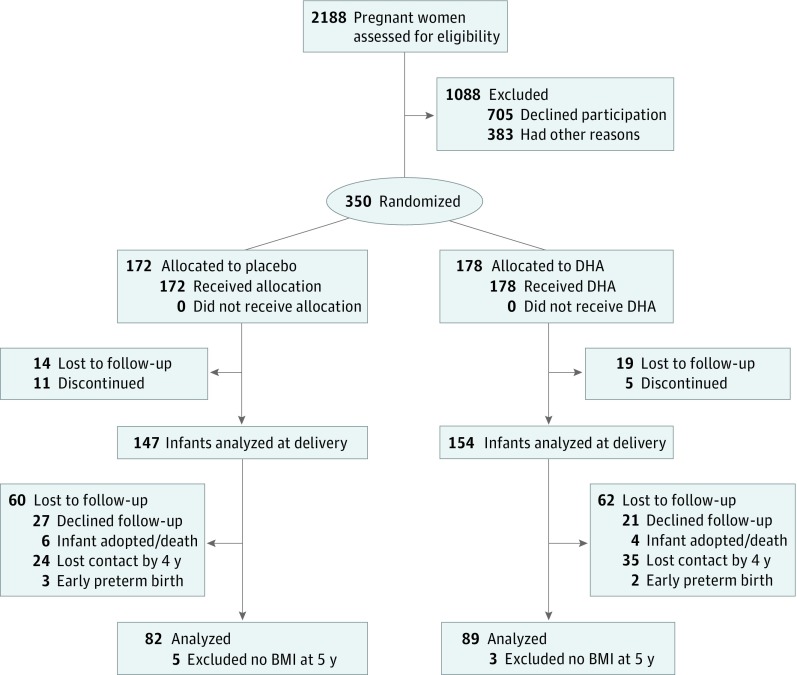
CONSORT Flow DiagramBMI indicates body mass index; DHA, docosahexaenoic acid.